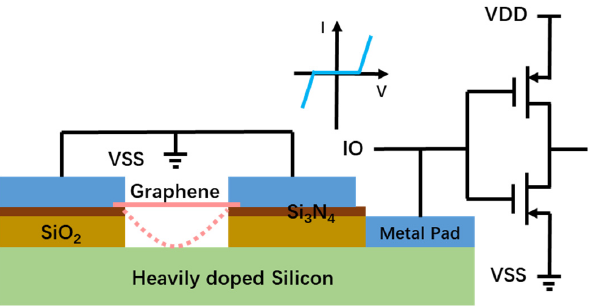
Figure 4. Cross-section of gNEMS ESD protection device in IC connection. Inset shows the symmet- ric ESD I–V